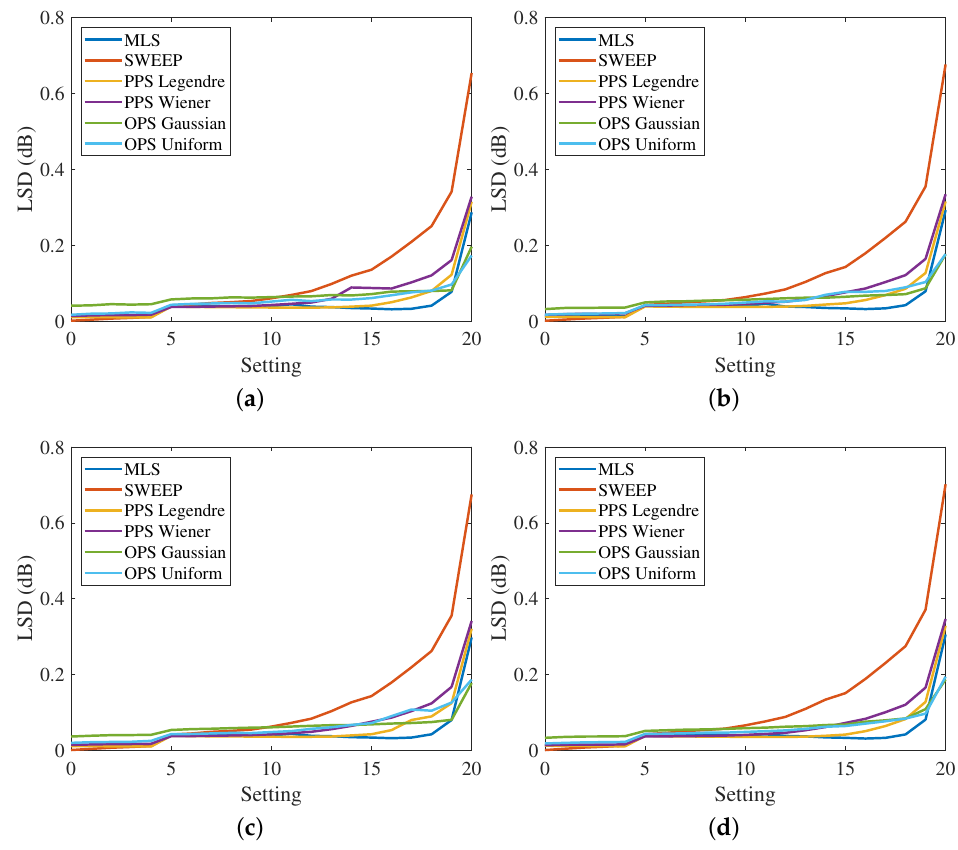
Figure 11. Log-spectral distance in the band [100, 18000] Hz at the different settings with the Electro Harmonix East River Drive pedal for ( a ) the response of the left ear from the left speakers, ( b ) the response of the left ear from the right speakers, ( c ) the response of the right ear from the left speakers and ( d ) the response of the right ear from the right speakers, and no artificially added noise, i.e., with SNR around 60